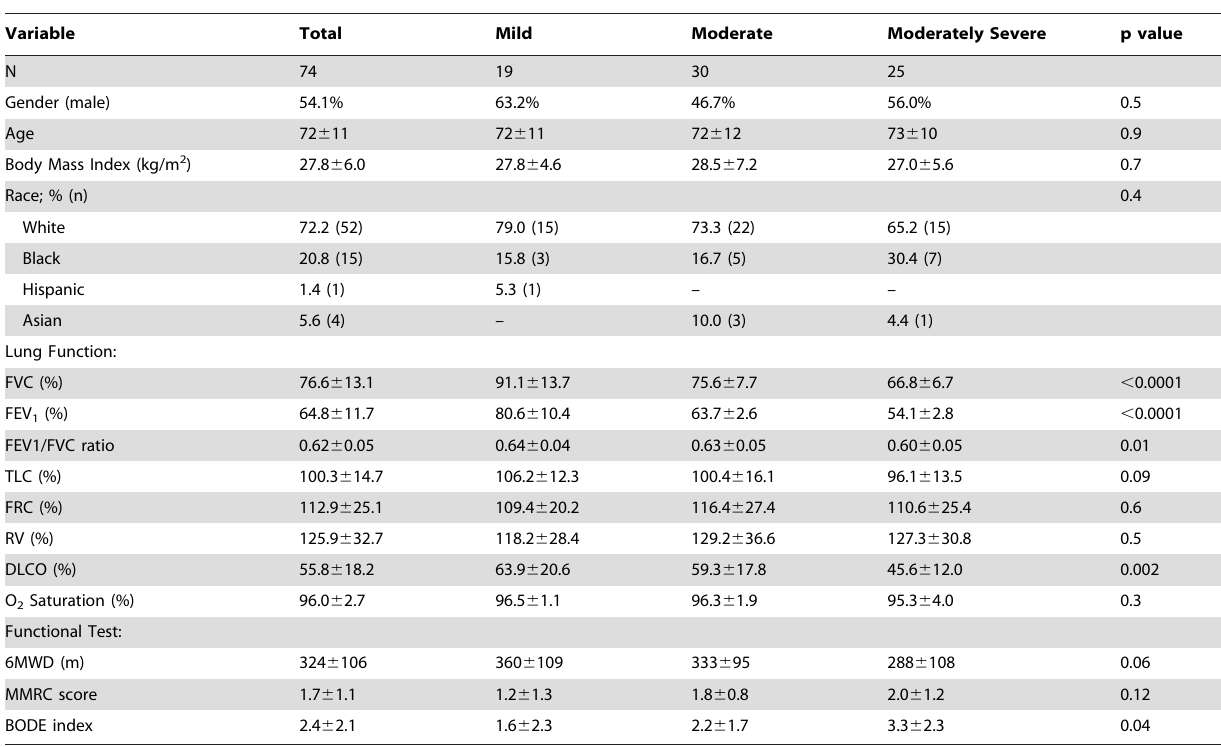
Table 1. Patient Characteristics.